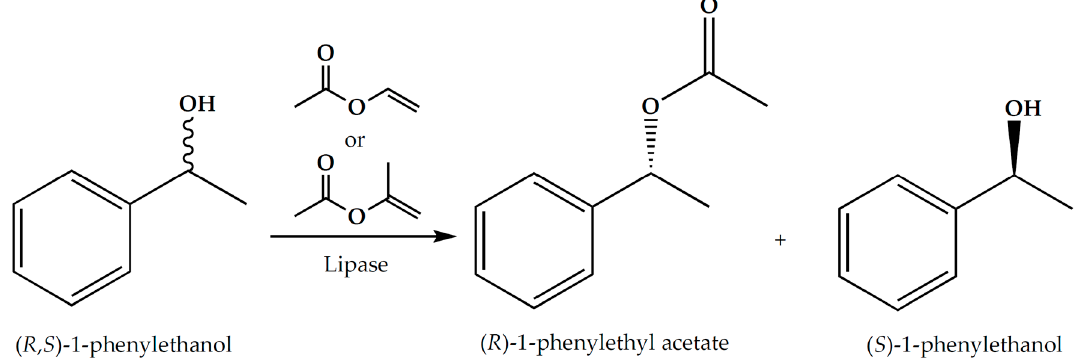
Figure 2. The kinetic resolution of ( R , S )-1-phenylethanol using various acyl donors: vinyl acetate or isopropenyl acetate.